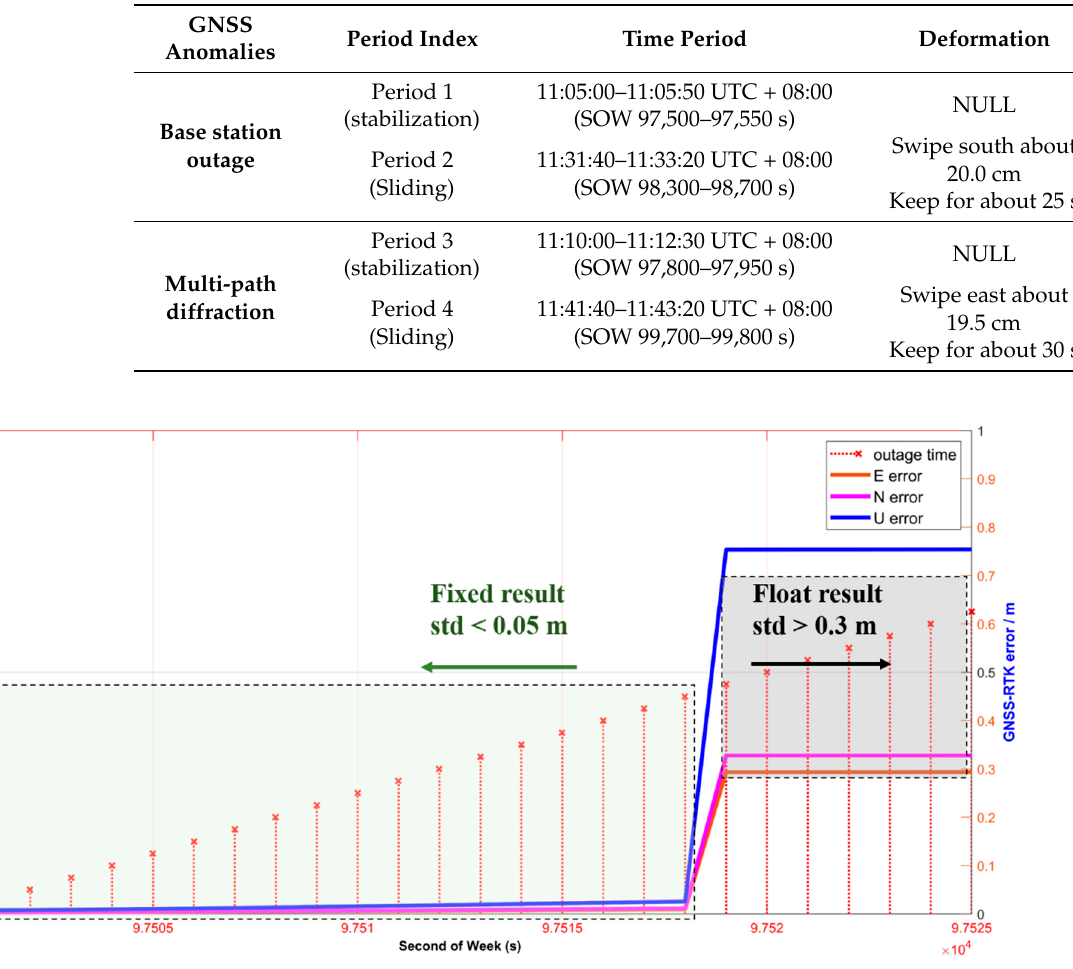
Figure 8. Coupled displacement results of the simulated landslide stability period in Scene 2.1. Simulate the Landslide Sliding Period In order to analyze the contribution of the GNSS/accelerometer coupled algorithm during the sliding period of the landslide in Scene 2.1, this study selected period 2, shown in Table 5, and artificially simulated a 25 s base station outage, wherein the RTK fixed solution without base station outage was treated as the reference. As shown in Figure 9, the GNSS float solution deviated from the reference by several tens of centimeters, while the GNSS/accelerometer coupled solution was more consistent with the reference. How- ever, the RMS also increased gradually during the outage of the base station. When the outage duration reached 20 s, the 3D RMS values were E—0.9 cm, N—1.3 cm, and U—1.5 cm, and after 25 s, they were E—6.9 cm, N—7.2 cm, and U—4.8 cm. (Figure 10). It could